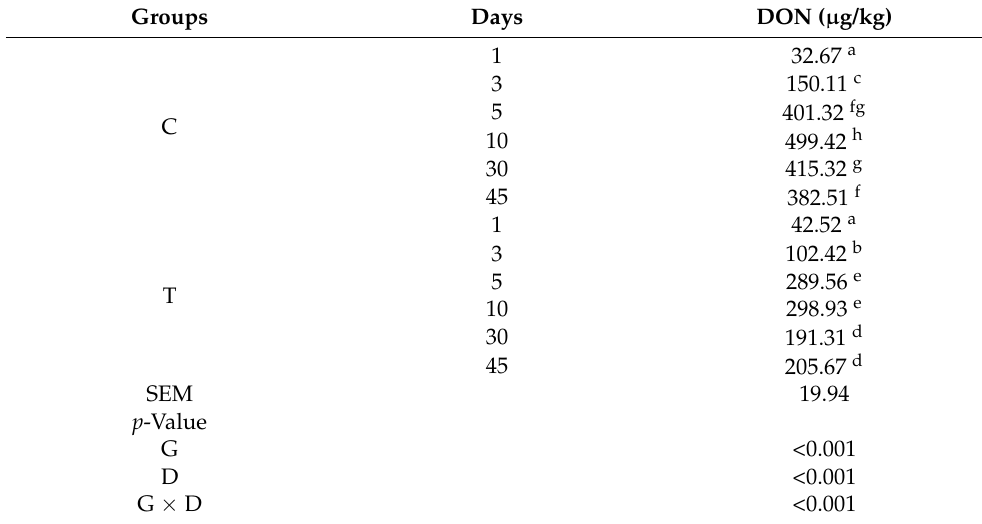
Table 3. Dynamic changes in the deoxynivalenol (DON) content in the two groups during the ensiling